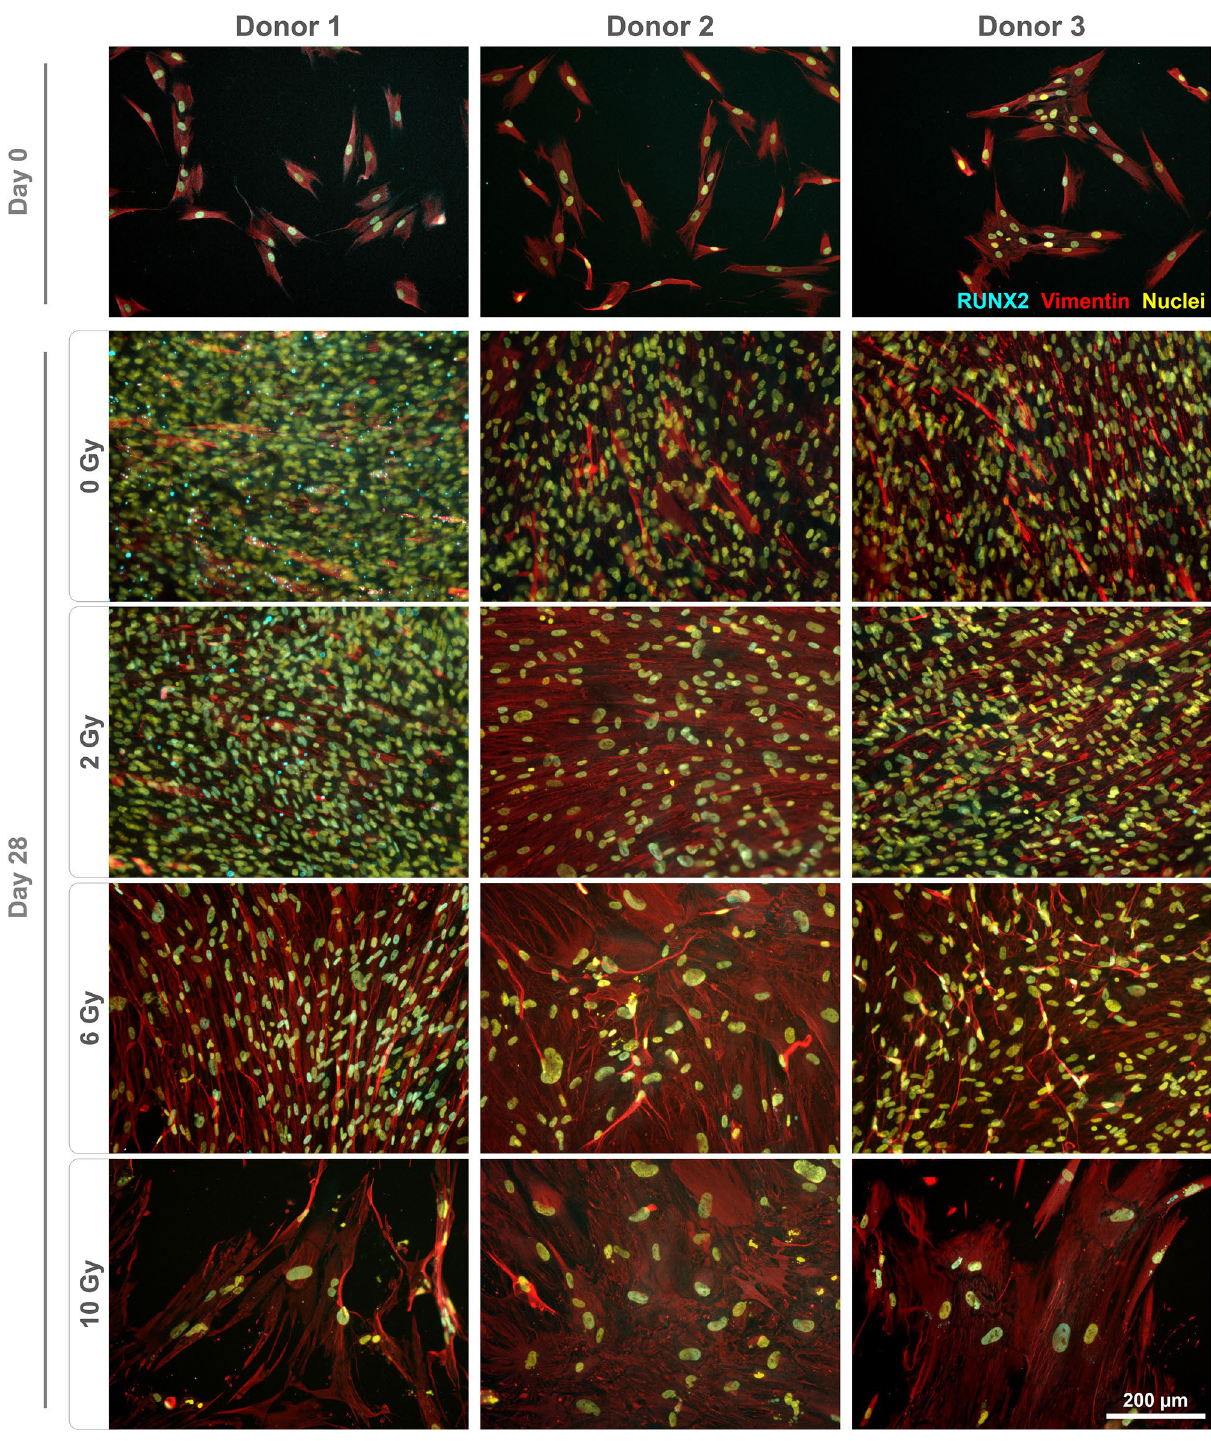
Figure 4. Immunostaining of irradiated JHOBs for RUNX2 and vimentin. Cells were irradiated with 2, 6 and 10 Gy or sham, and stained for expression of RUNX2 (cyan) and vimentin (red) after 28 days of cultivation in osteogenic medium. Non-treated cells on day 0 were used as a control. Nuclei were counterstained with DAPI